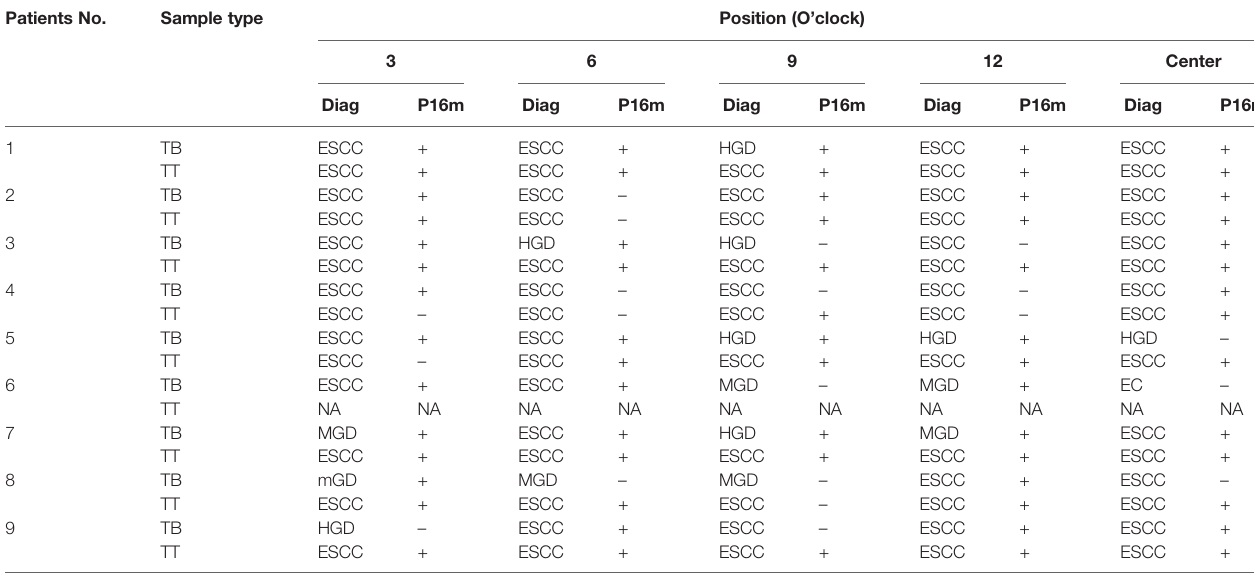
TABLE 4 | Diagnosis and p16 methylation status of 40 tumor tissues and 45 tumor biopsies. Patients